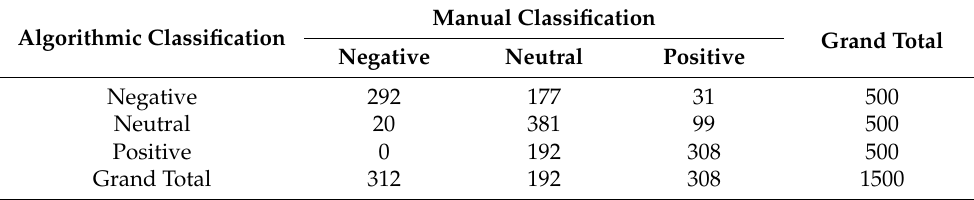
Table 2. Validation of initial TF-IDF+LR sentiment classification.